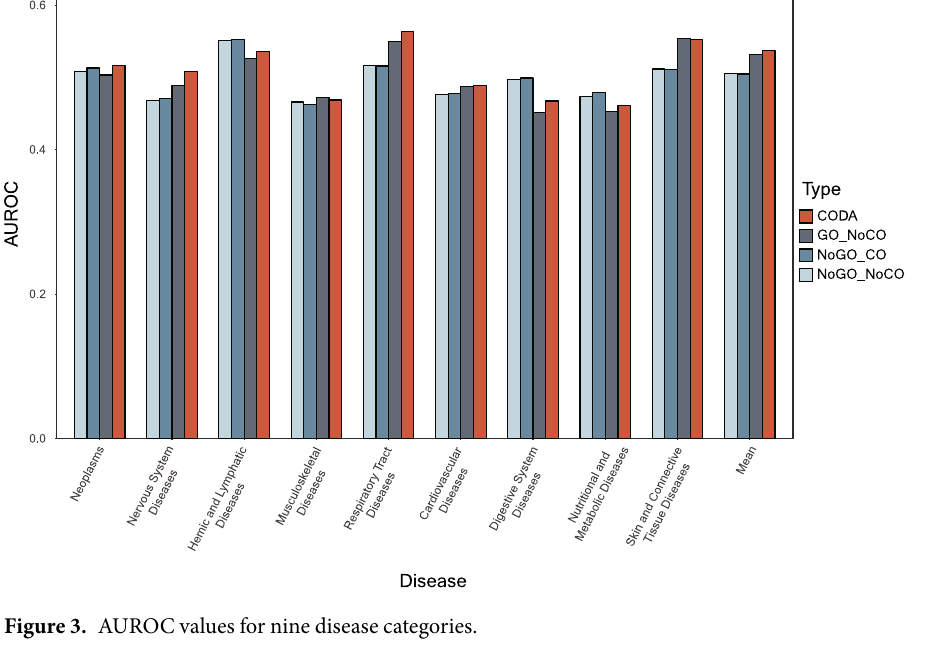
Figure 3. AUROC values for nine disease categories.